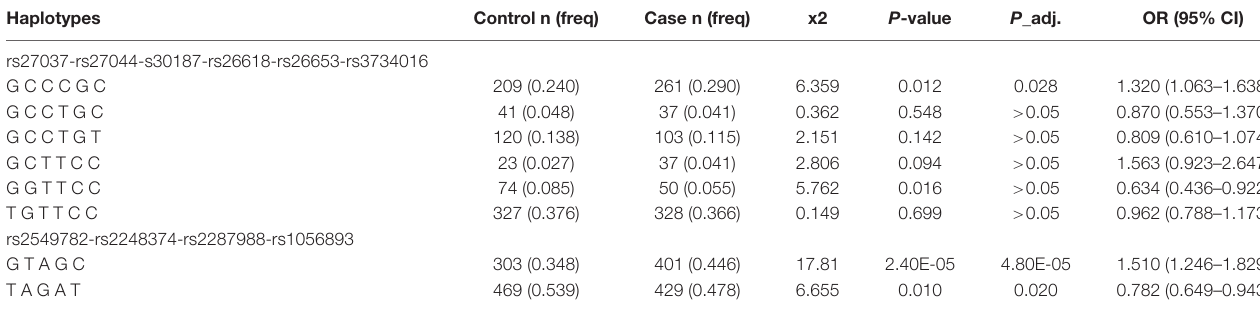
TABLE 4 | The major ERAP1 and ERAP2 haplotypes in the TB and the case